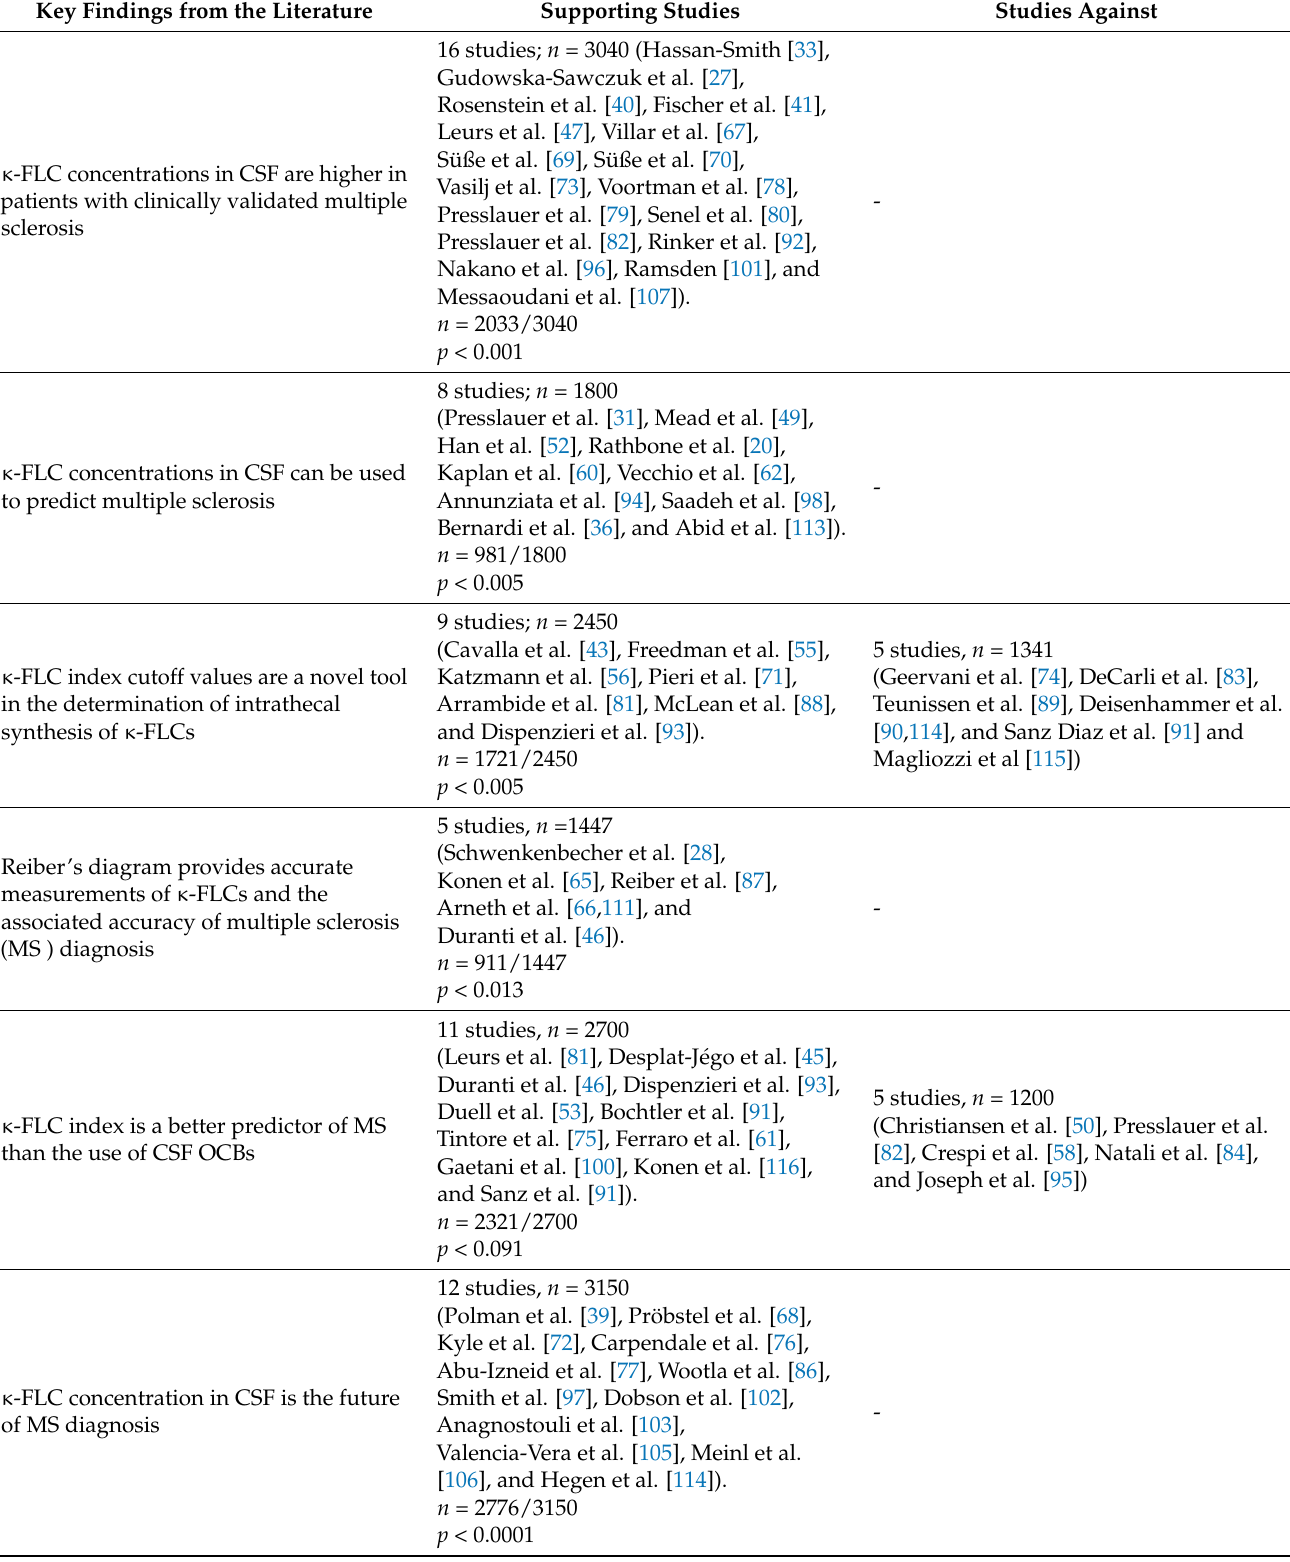
Table 2. Key findings for Kappa Free Light Chain ( κ -FLC ) Effectiveness in the Diagnosis of Multiple